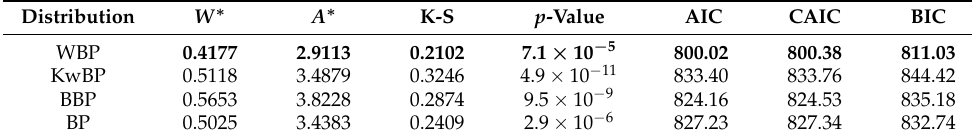
Table 6. Adequacy measures for COVID-19 data in Florianópolis.